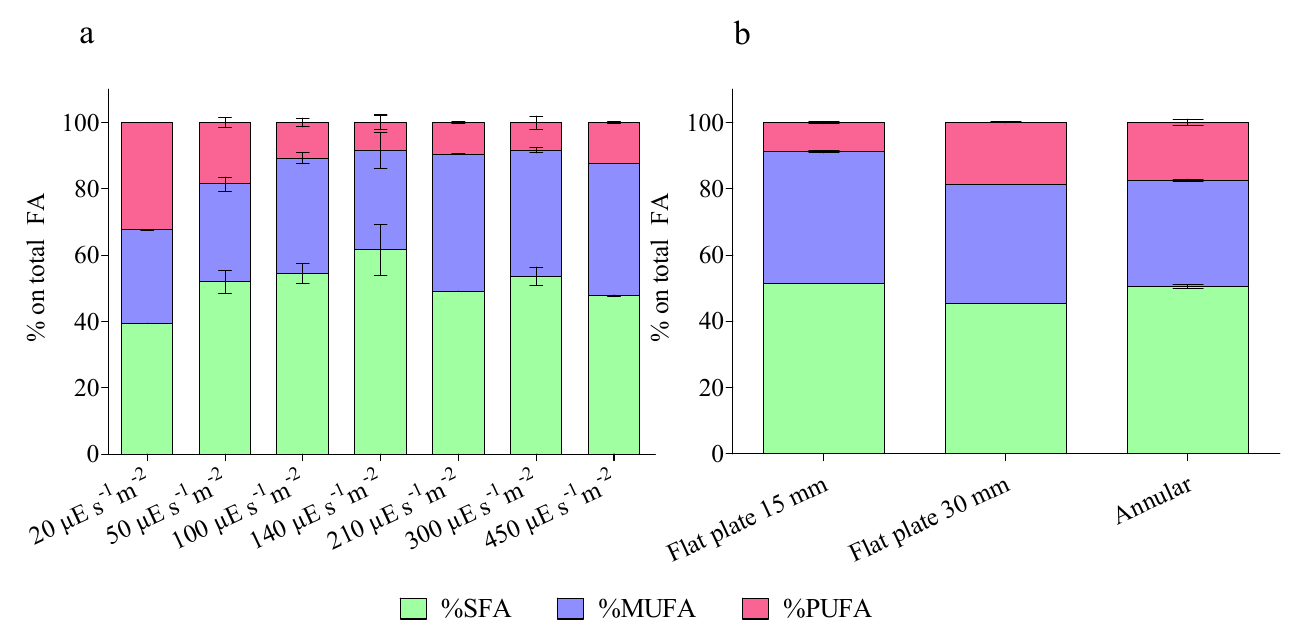
Figure 9. Fatty acid analysis as percentage of total fatty acid content in the biomass obtained at the end of the batch cultivations grown under different conditions: ( a ) quasi-isoactinic reactor with different photon flux densities; ( b ) reactors with different configurations at incident light intensity I 0 = 210 µ E s − 1 m − 2 . SFA, saturated fatty acid; MUFA, monounsaturated fatty acids; PUFA: polyunsaturated fatty acid.